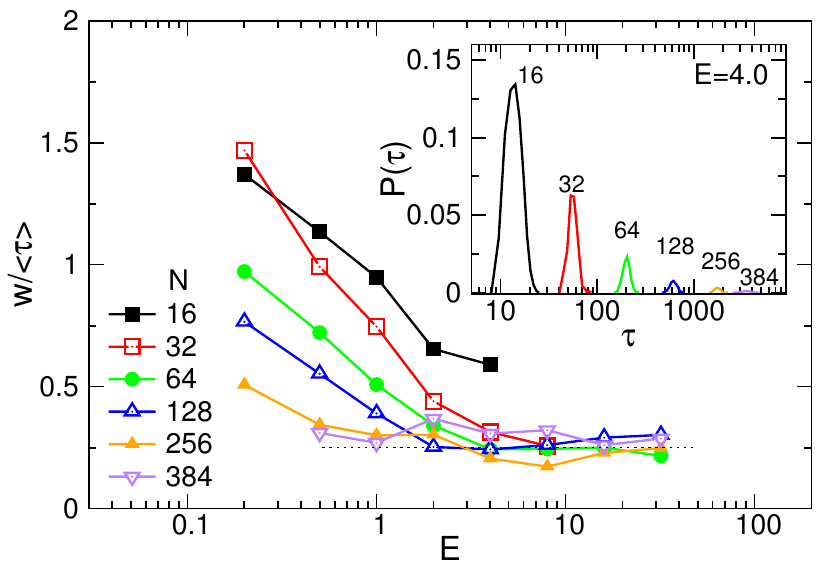
Figure 4. w / (cid:104) τ (cid:105) as a function of E for different N . (Inset) Probability distributions P ( τ ) of translocation time at E = 4.0. The number N is indicated near the